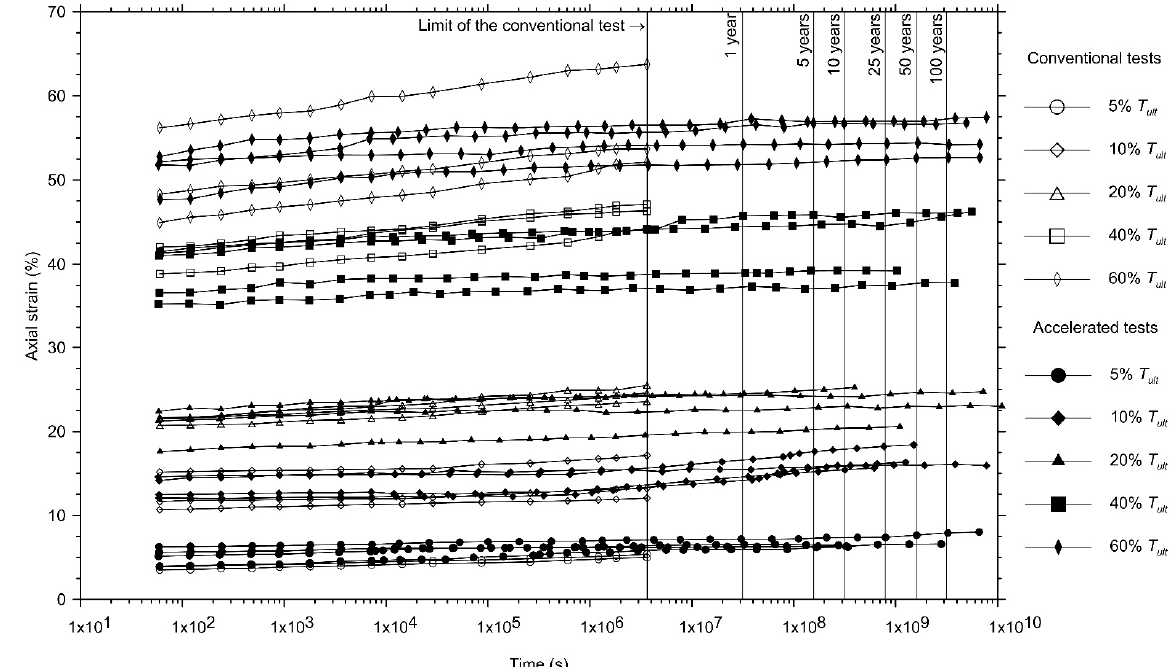
Figure 3. Comparison between the creep curves obtained using conventional creep tests and the master curves obtained by accelerated creep tests for the non-woven needle-punched geotextile manufactured with short-staple fibres (GTXnwS).